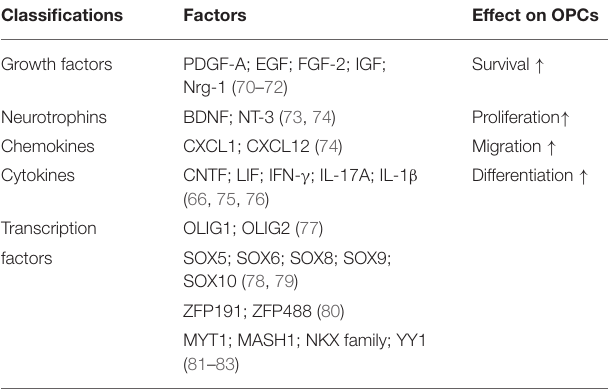
TABLE 4 | Factors regulate remyelination via different effects on OPCs.